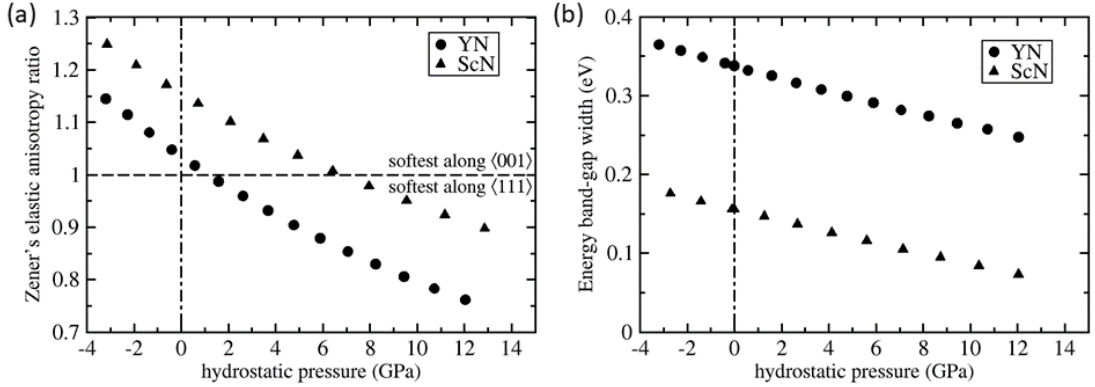
Figure 5. Quantum-mechanically computed ( a ) dependence of the Zener elastic anisotropy ratio A Z and the band-gap energy ( b ) as a function of hydrostatic pressure for both YN and ScN. The horizontal dashed line for A Z = 1 represents the border value of the elastic anisotropy, the vertical dash-dotted line corresponds to zero hydrostatic